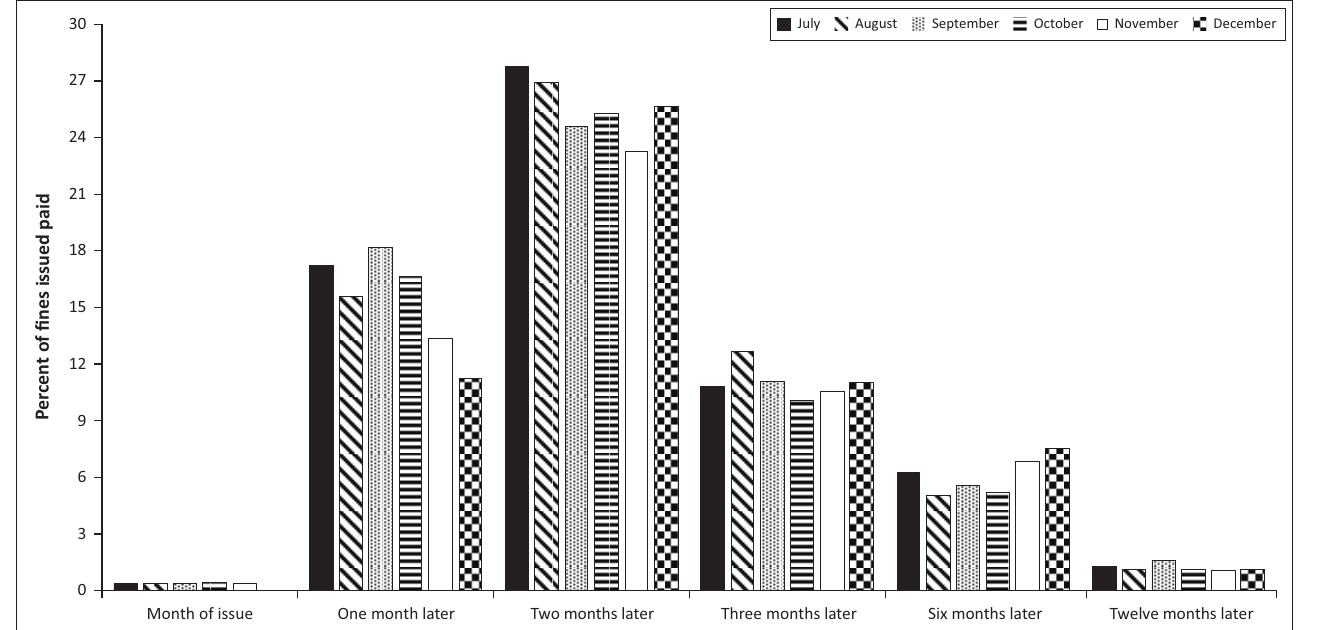
FIGURE 4: Evolution of payments for speeding-related fines issued from July 2014 to December 2014 (percentages of issued